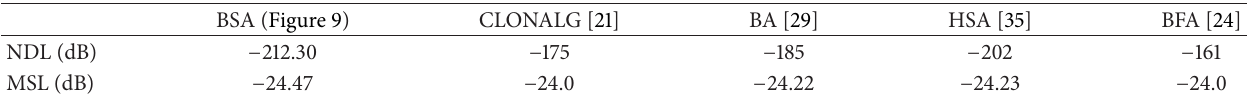
Table 3: NDL and MSL values obtained by BSA and other optimization techniques CLONALG [21], BA [29], HSA [35], and BFA [24] for one null imposed at − 10 ∘ .